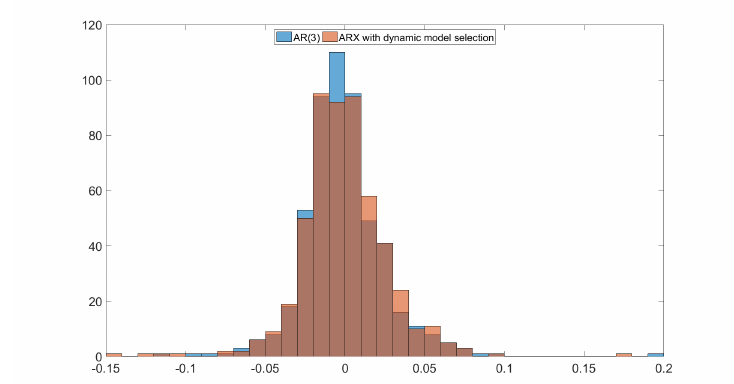
Figure A7. Evolution of an initial investment of 100 USD in PL and L&S strategies based on complete and incomplete panel data over the out-of-sample period from December 30, 2005 until February 5, 2016. All strategies are weekly rebalanced and have zero transaction costs.